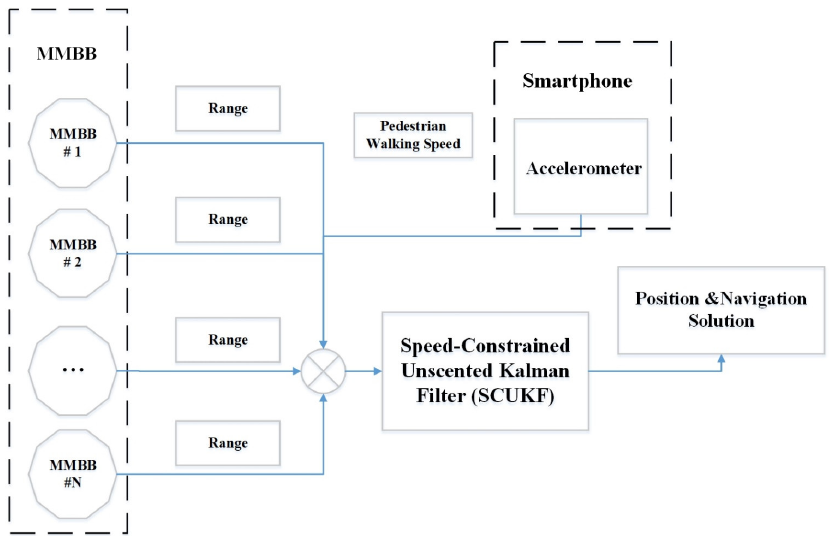
Figure 3. Tightly coupled integration.